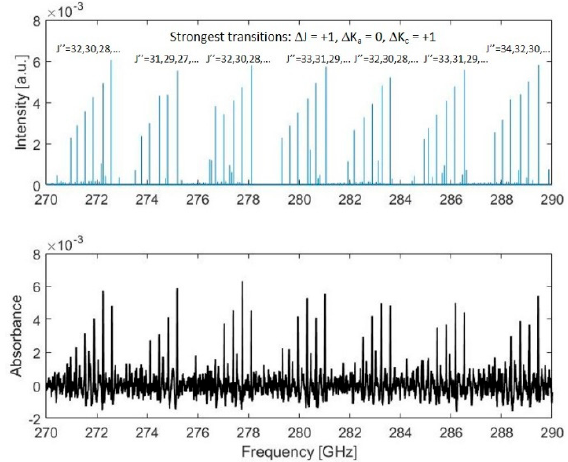
Figure 6. Comparison of measured absorbance (bottom) with line positions and intensities for the ground vibrational state simulated using PGOPHER [33] and the rotational constants of Cuisset et al. [27] in the 270–290 GHz frequency